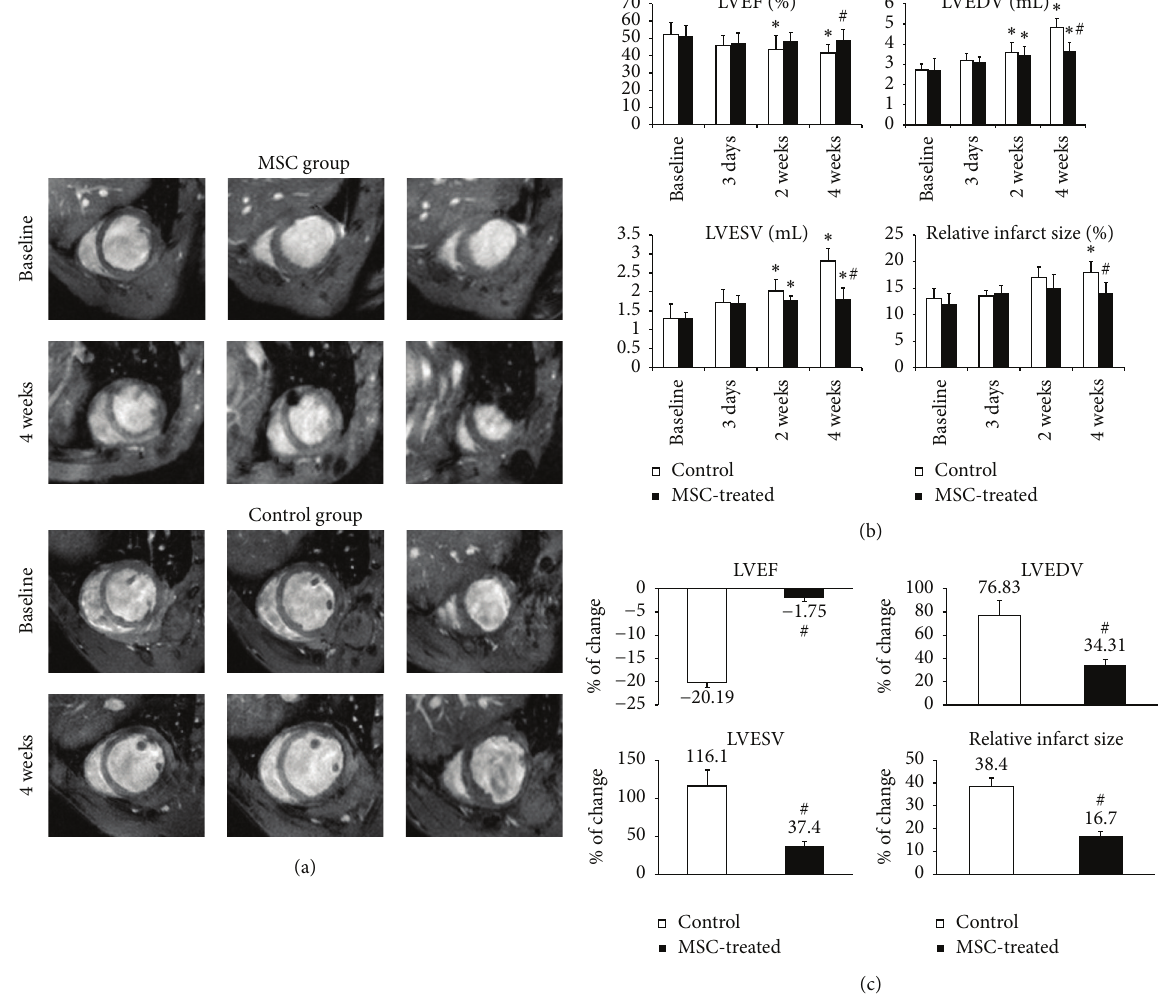
Figure 2: MRI assessment of cardiac morphology and function. (a) The typical course after myocardial infarction including progressive scar thinning, left ventricular dilatation, and functional deterioration was observed in both groups at baseline. However, serial cine-MRI studies between baseline and 4 weeks showed that MSCs injection resulted in moderated LV dilatation and dysfunction compared with controls (b–c). 𝑁 = 9,9, 8, 8 for MSCs group and 𝑁 = 10, 9,9,8 for control group at each time point. ∗ 𝑝 < 0.05 versus baseline; # 𝑝 < 0.05 versus